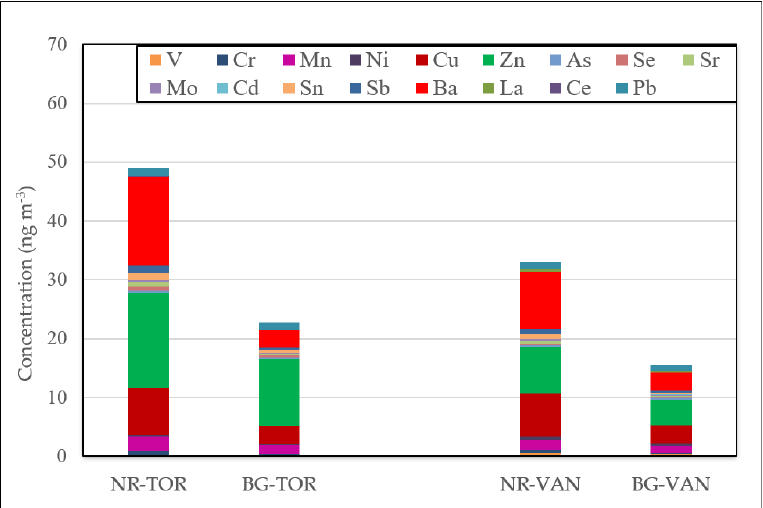
Figure 2. Median concentration of trace elements in PM 2.5 samples collected over the study period listed in Table